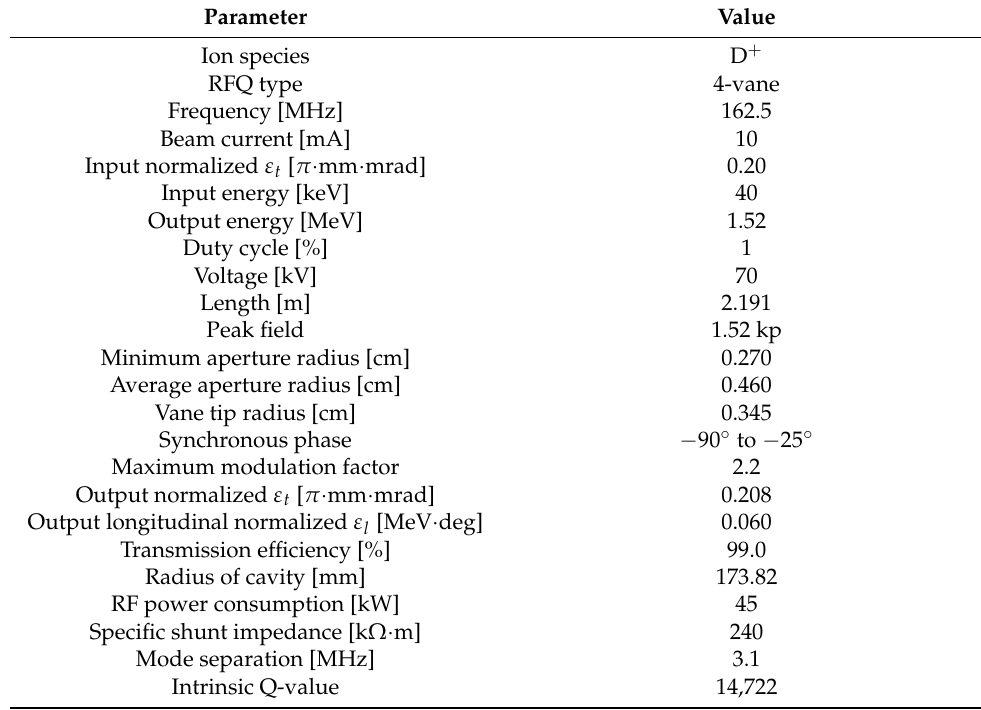
Table 1. Main physics parameters of the